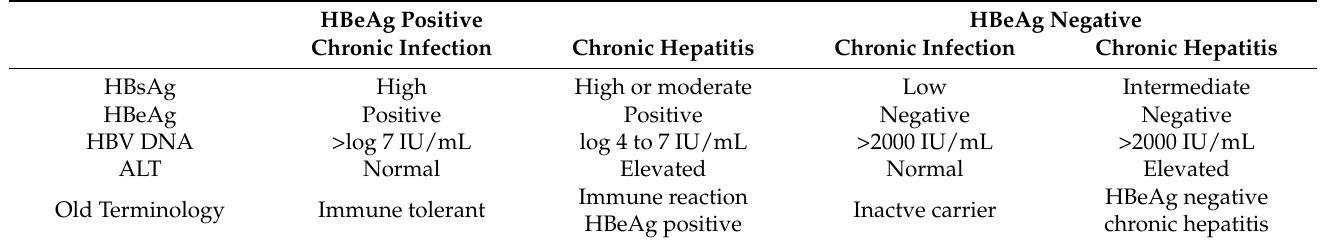
Table 2. The phases of the natural history and assessment of patients with chronic HBV infection as characterize by EASL-2017. HBeAg Positive HBeAg Negative Chronic Infection Chronic Hepatitis Chronic Infection Chronic